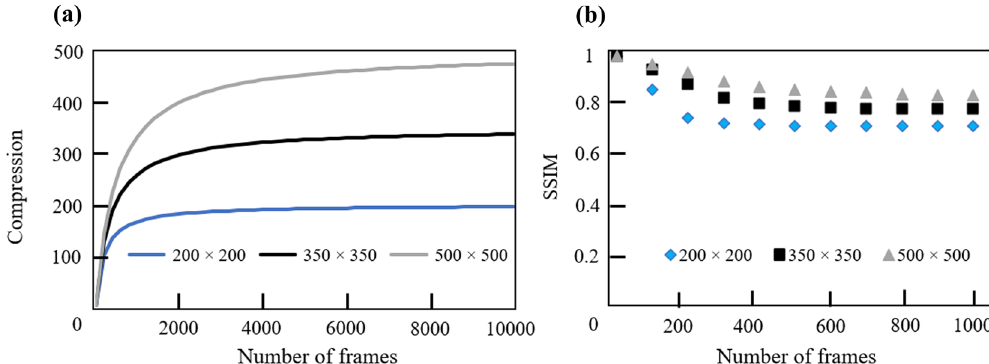
Figure 9. Graphs of the ( a ) compression ratios and ( b ) SSIM measurements against number of frames in CCRM